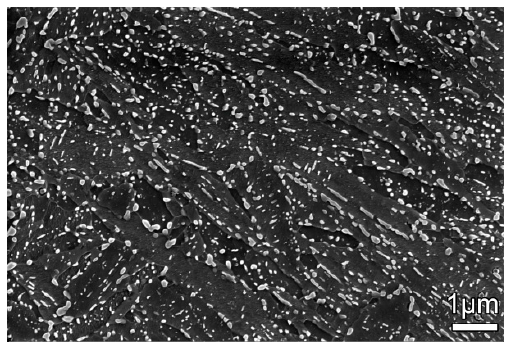
Figure 1. Secondary electron imaging (SEI) image showing the microstructure of the starting material.